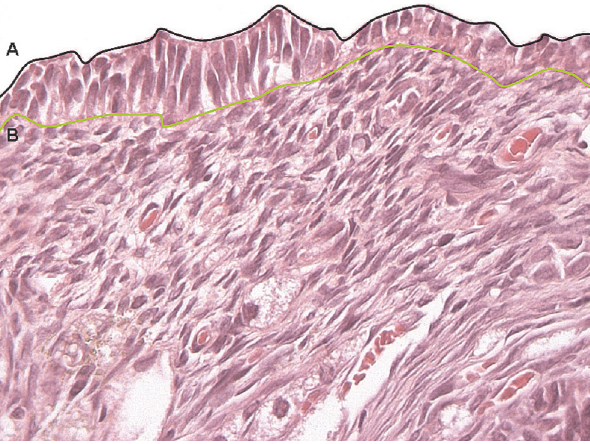
Figure 1 - Photomicrography showing the cortical region of an ovary in 1.25 mm extension. Letters indicate the delimitation applied to histomorphometric parameters. A) tracing along the superficial epithelial cells. B) tracing along the epithelium-stroma interface. Staining: H&E. Magnification: